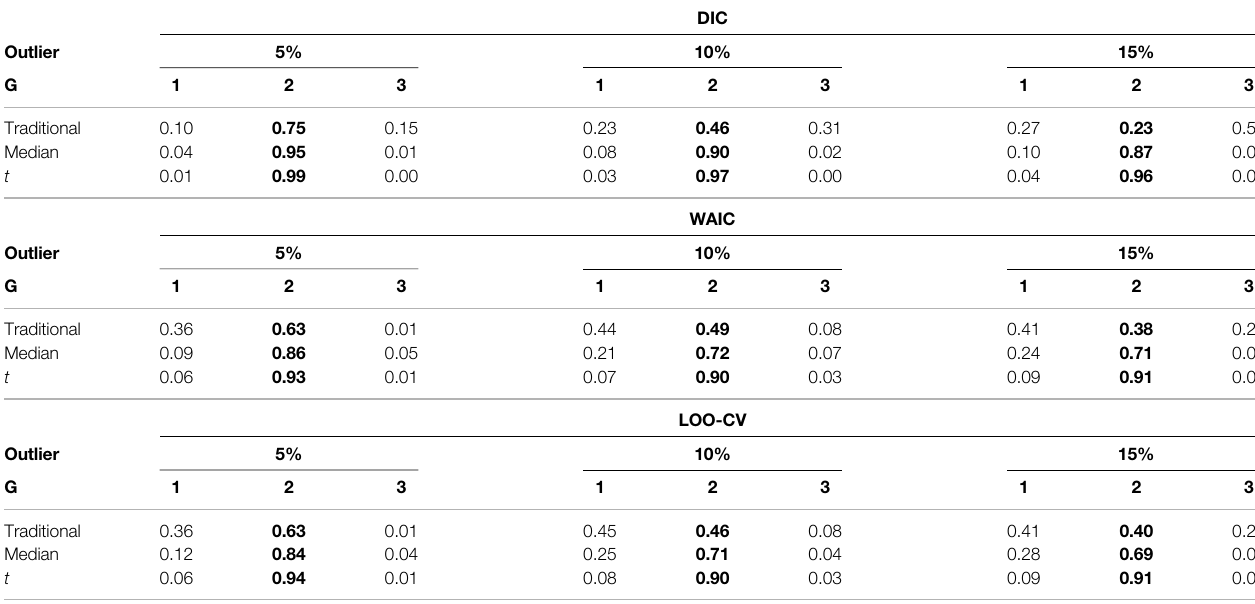
TABLE 4 | Proportion for selecting 1-class, 2-class, and 3-class models using DIC, WAIC, and LOO-CV when N (cid:1) 300.